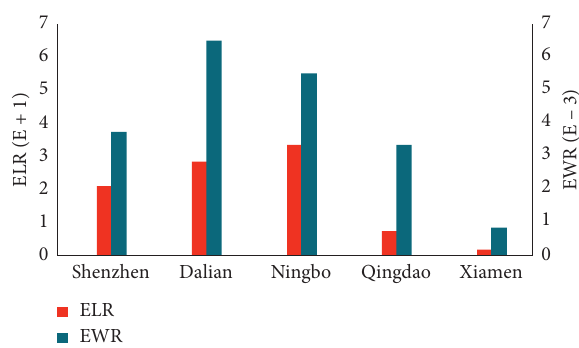
Figure 5: ELR and EWR of each city in